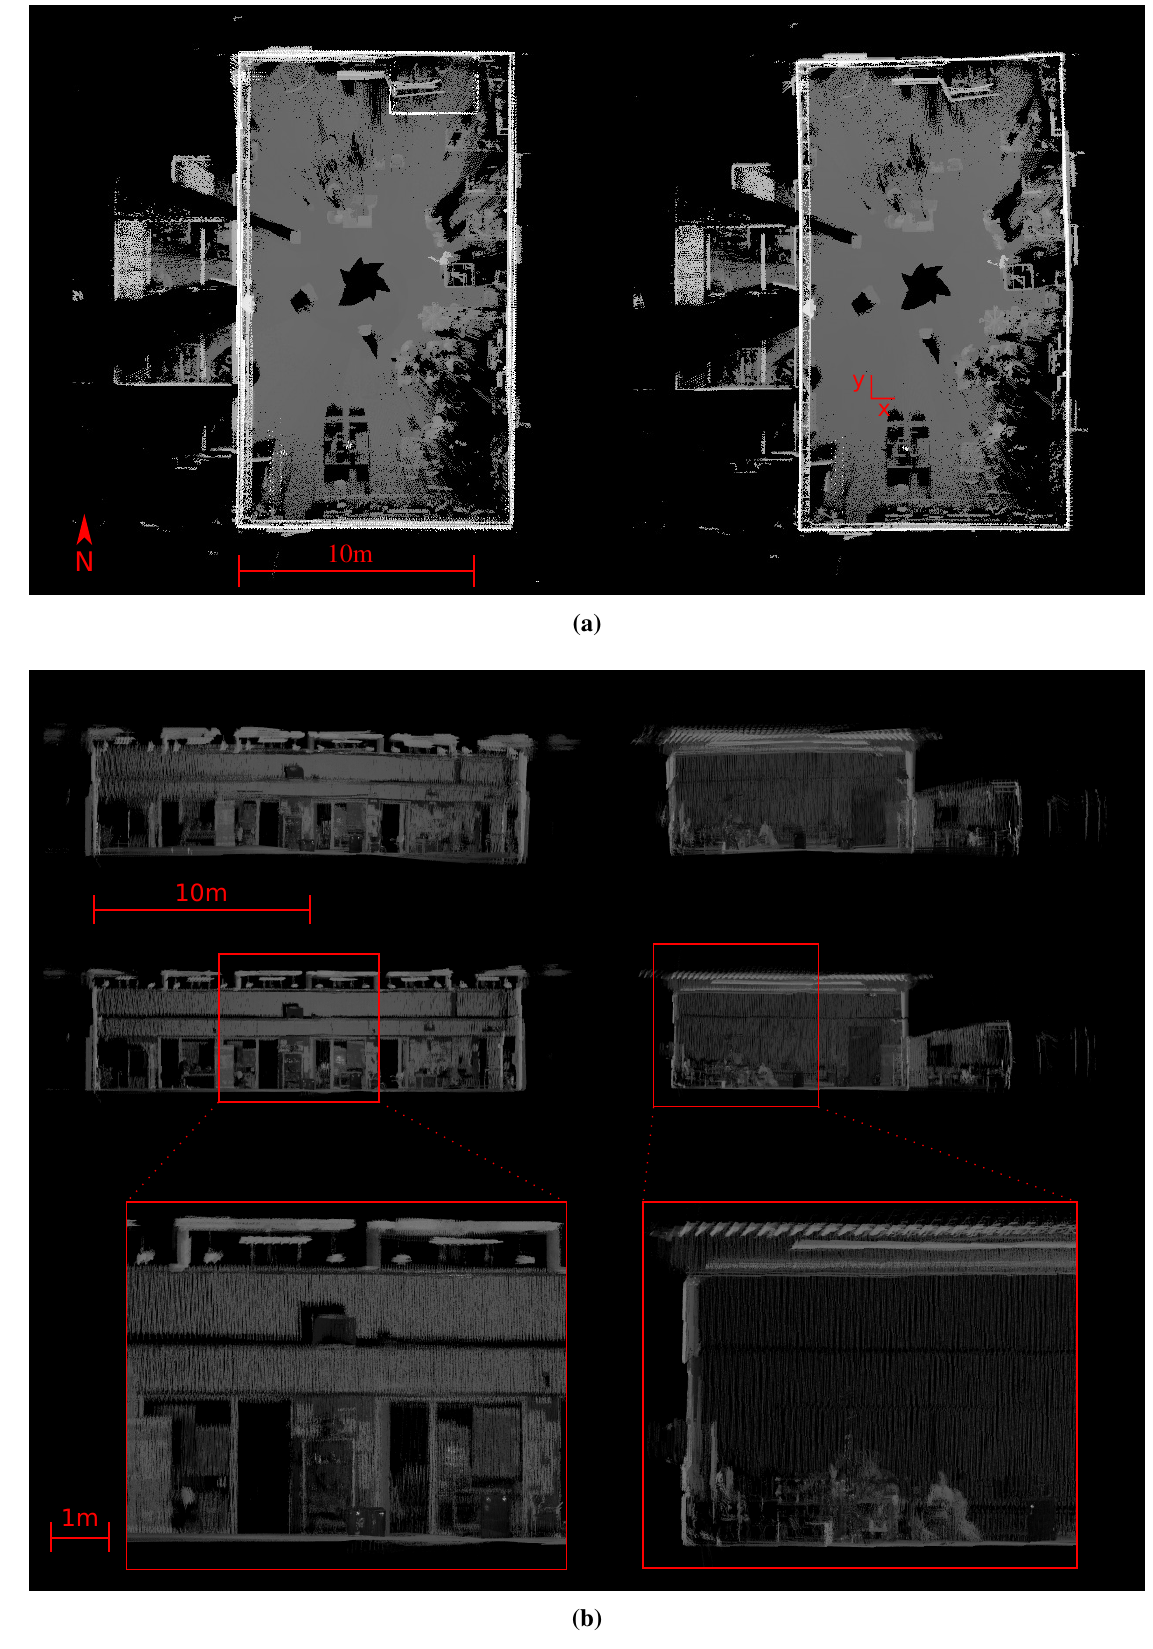
Figure 10. 3D point cloud of Experiment 3. ( a ) Bird’s eye view. The thickness of the walls decreased by optimization. Depicted is the origin of the iSpace coordinate system; ( b ) Side view before (top) and after (bottom)